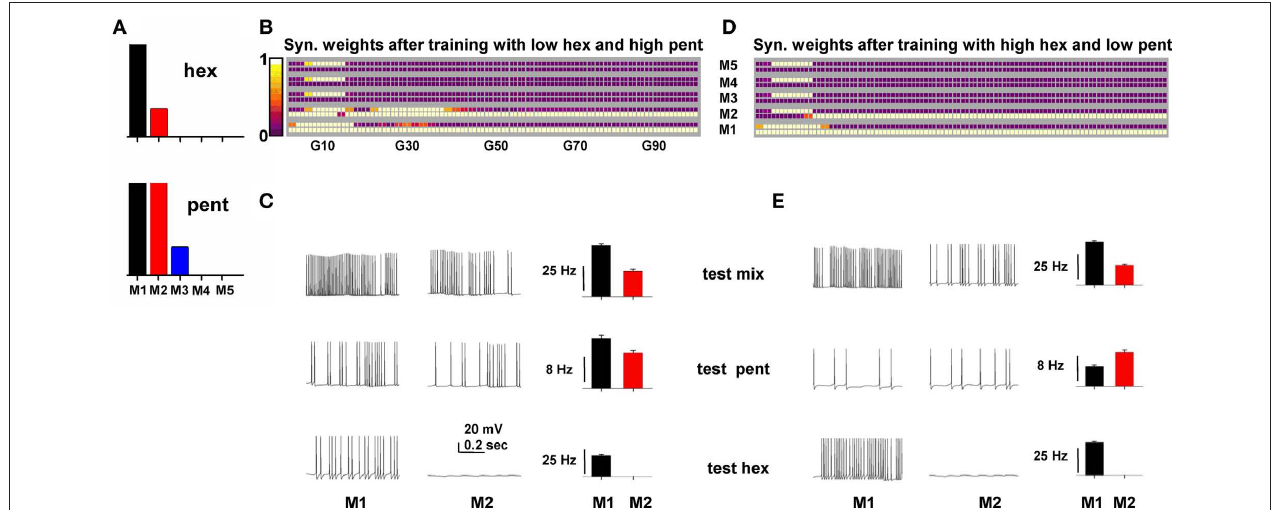
FIgure 7 | A network trained on an overlapping binary mixture can demonstrate both elemental and overshadowing responses. (A) Relative strength of the synaptic input on the tuft of each mitral cell (M1–M5) to model hexanal (hex) and pentanal (pent) simulation. (B) Synaptic weights after training with a mixture of low hex and high pent. (C) Typical somatic traces ( left ) and average firing rate for M1 and M2 ( right